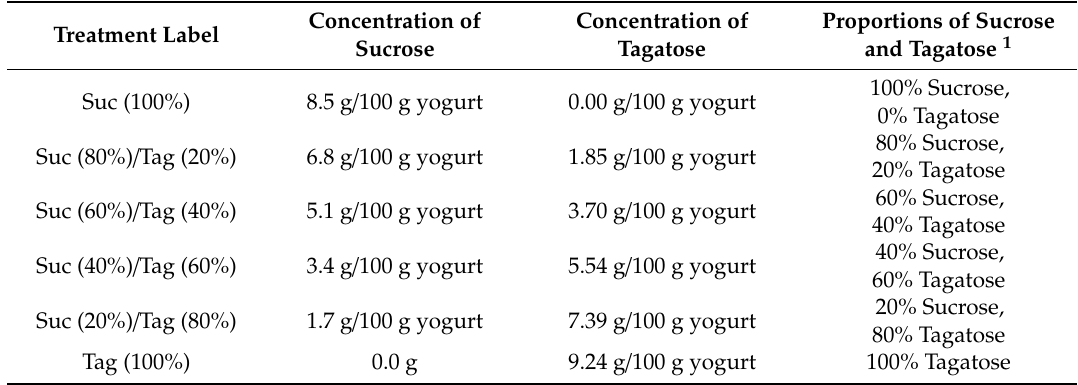
Table 1. Formulations 1 of the di ff erent sucrose concentrations for the strawberry-flavored yogurt samples. Concentration of Concentration of Proportions of Treatment Label Sucrose Tagatose